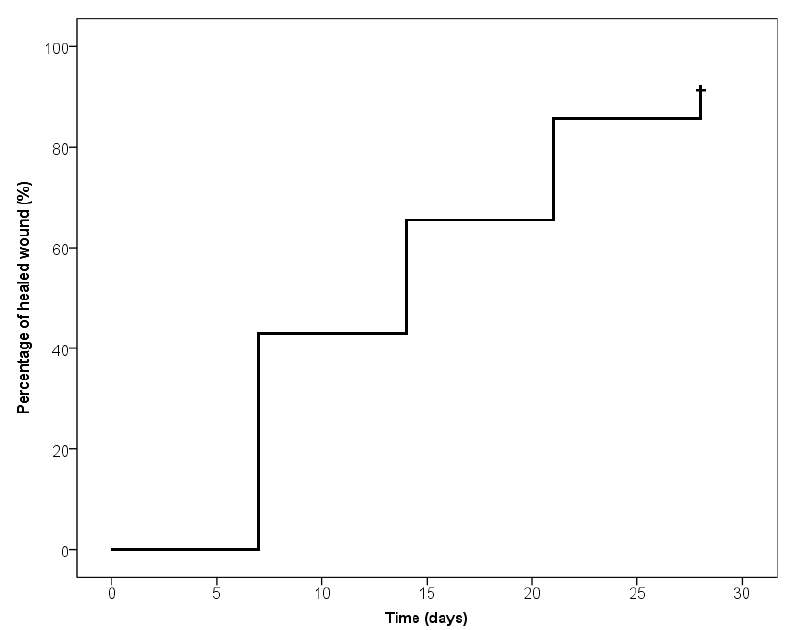
Chart 4. Kaplan-Meier plot. The percentage of completely healed-wound during the observation